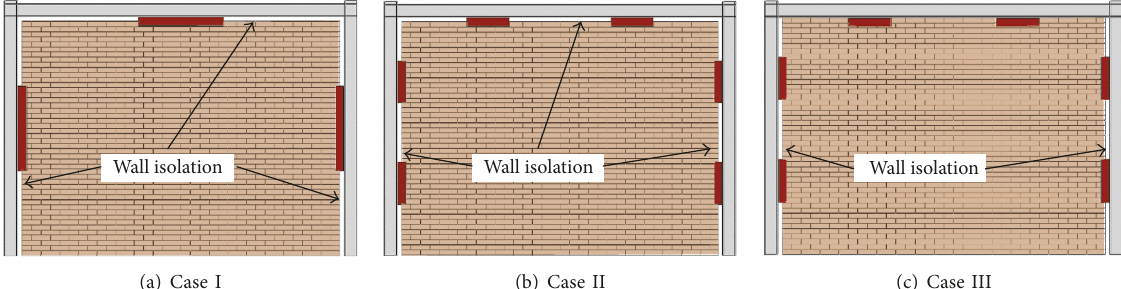
Figure 2: Considered frame-infill configurations.